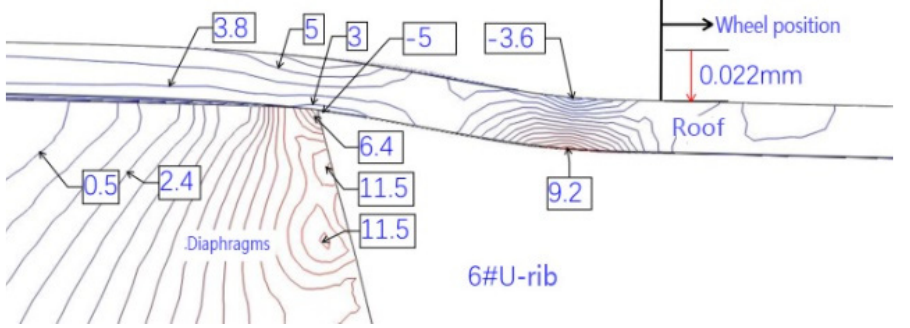
Figure 11. Principal-stress contour of the vertical plane at the junction of roof, U-rib, and diaphragm.